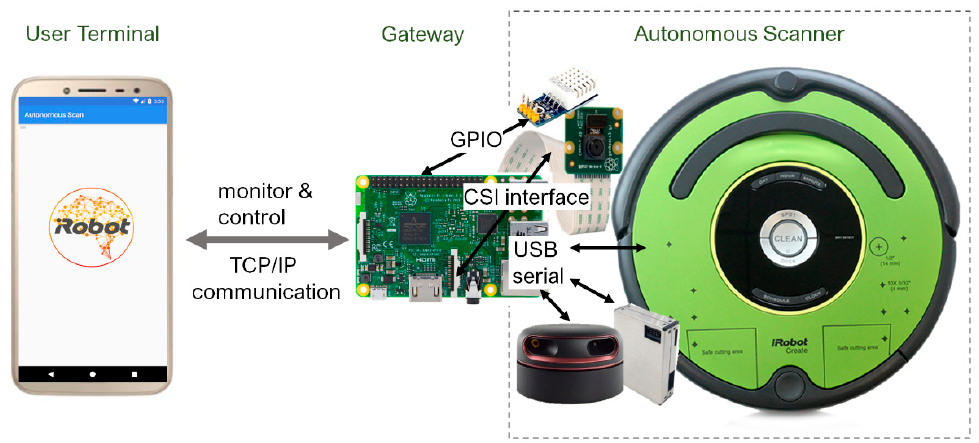
Figure 6. Prototype architecture of proposed autonomous scanning system. The user terminal exchanges data with the gateway via TCP/IP communication. The autonomous scanner components are connected to the gateway directly.